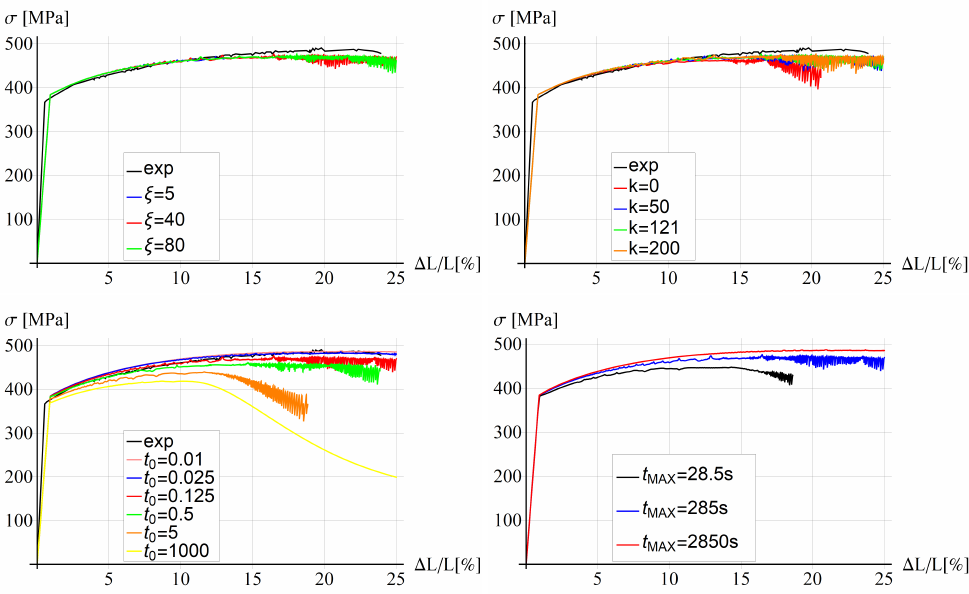
Figure 7. Stress vs. relative extension for different values of viscosity ( top , left ), conductivity ( top , right ), solute diffusion time ( bottom , left ) and maximum tension time ( bottom , right